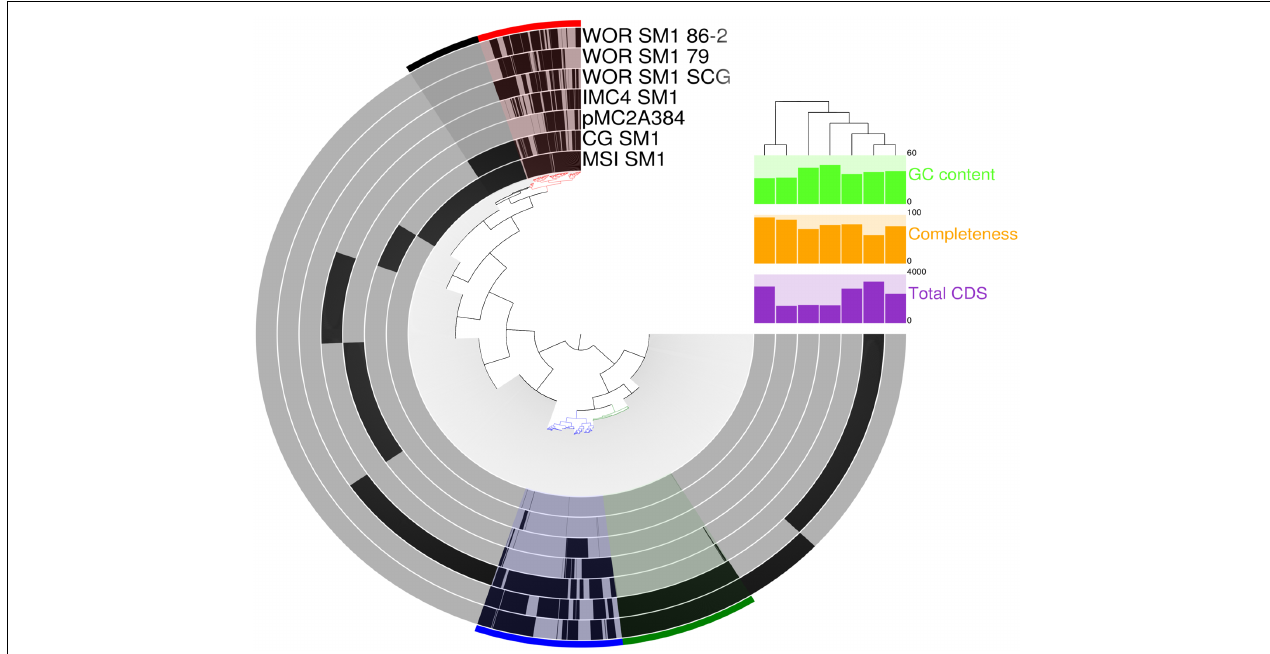
FIGURE 5 | Comparative analysis of protein clusters within all known Altiarchaeales genomes. The inner tree was constructed from matrix of protein abundances across the distantly related genomes in this study. Black bars at the tips of inner tree represent the presence or absence of a protein within a genome. Colored bins across the edge highlight co-occurrence patterns across the genomes: core Altiarchaeales proteins (red), core Alti-1 (black), core Alti-2 (blue), and homologous proteins between WOR genomes from metagenomes (green). GC content (bright green), predicted completeness (orange), and total predicted coding sequences (purple) are displayed to the right. Branch lengths in the tree above the histograms correspond to dissimilarities between predicted coding sequences in the